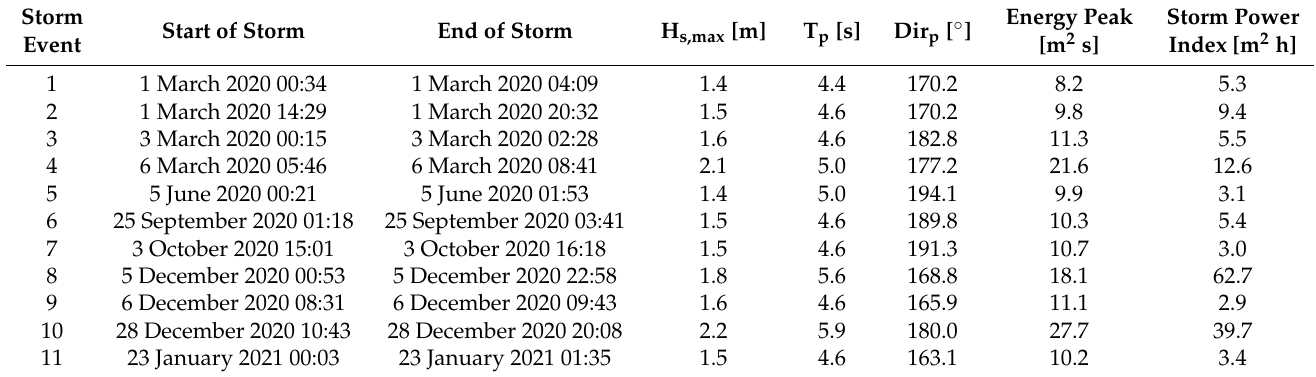
Table 4. Energy peaks and storm power indices for 11 defined storm